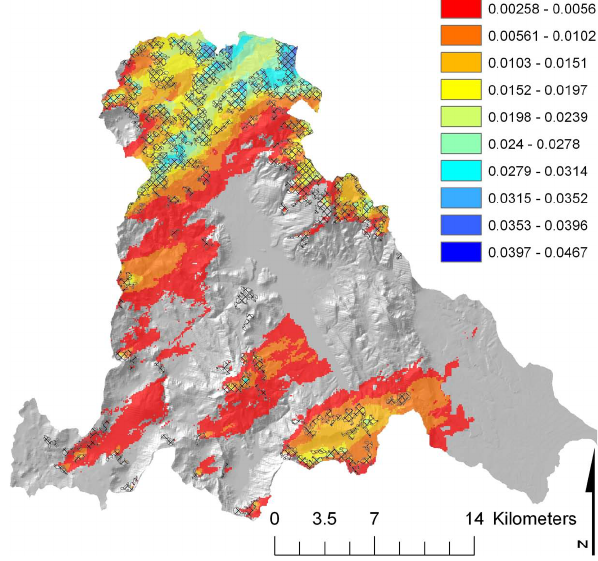
Fig. 3. Difference in burn probability between the non-treatment and treatment scenario. Areas not shaded within the watershed boundary had differences less than 0.00258.